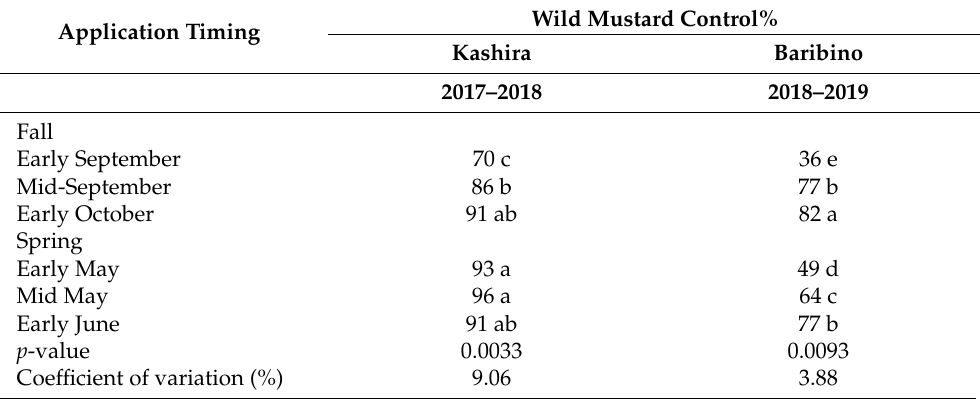
Table 2. Wild mustard control by different glyphosate application (430 g ai ha − 1 ) timings used pre-plant to spring wheat, at spring wheat harvest in two